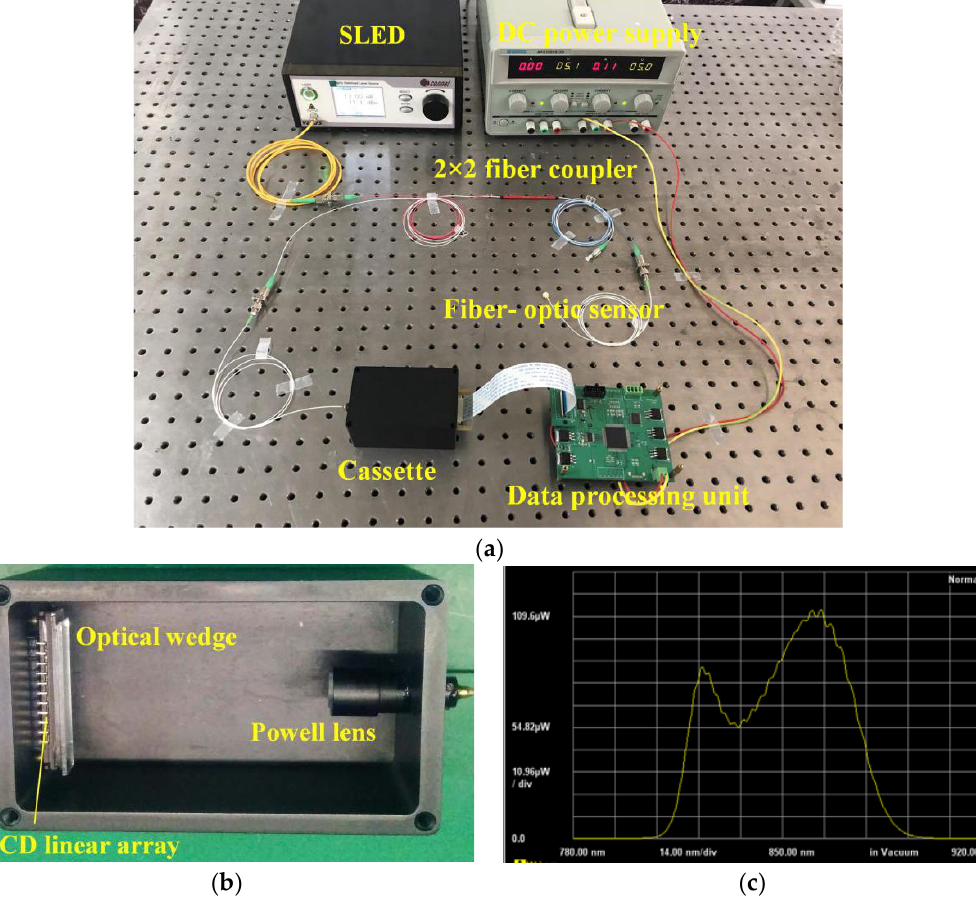
Figure 5. Experimental setup of the white light non-scanning correlation interrogation system. ( a ) Picture of the whole system, ( b ) inner structure of the cassette, ( c ) optical spectrum of the SLED.